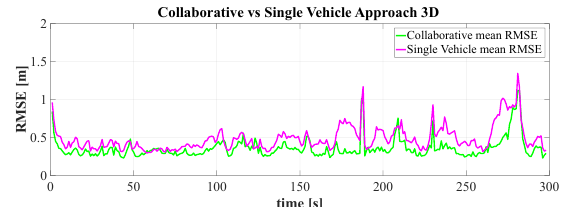
Figure 14. Collaborative approach (Sensor setup 1) VS Single Vehicle approach (Scenario 4).